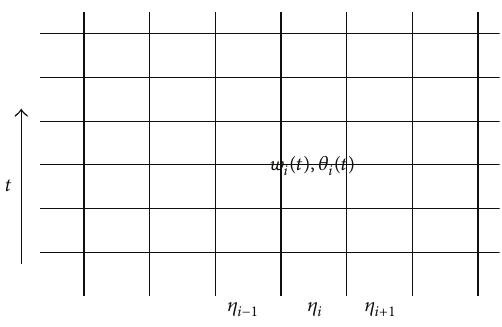
Figure 2: Computational domain with